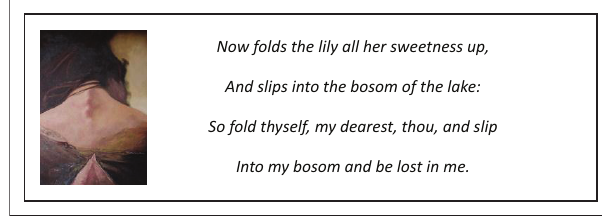
FIGURE 7: Now Sleeps the Crimson Petal: ‘The Journey’.